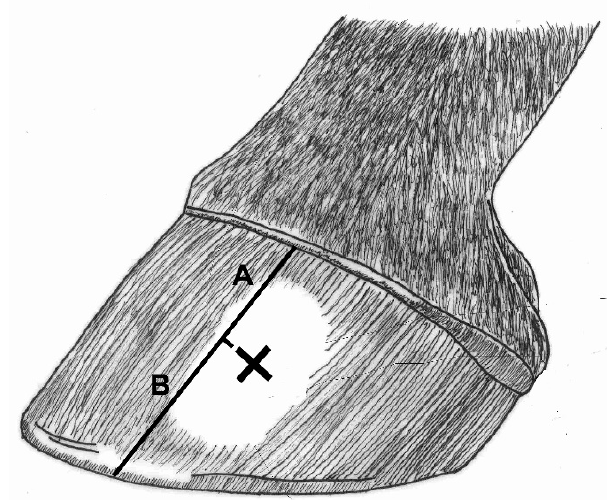
Figure 3. An example of a lateral cross mark burned into the horse’s hoof with a wood burning tool. The measurement of hoof growth (A) and hoof wear (B). The lines are offset for illustrative purposes only.